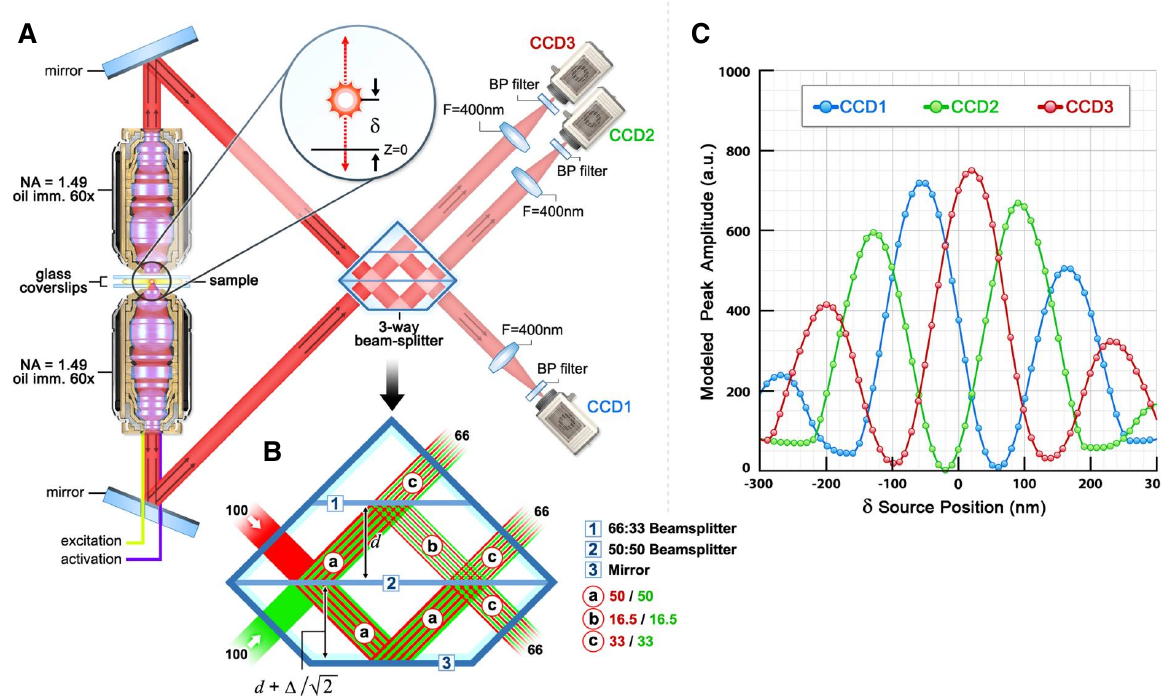
Figure 3. Schematics and operating principle of multiphase interferometric microscope illustrating how z-position is resolved. ( a , b ) Schematic of the single-photon multiphase fluorescence interferometer. A point source with z-position δ emits a single photon both upwards and downwards. These two beams (color-coded as red and green in ( b ) interfere in a special three-way beam splitter. ( c ) The self-interfered photon propagates to the three color-coded charge-coupled device (CCD) cameras with amplitudes that oscillate 120° out of phase as indicated. a.u., arbitrary units; BP, band pass; NA, numerical aperture. Taken from